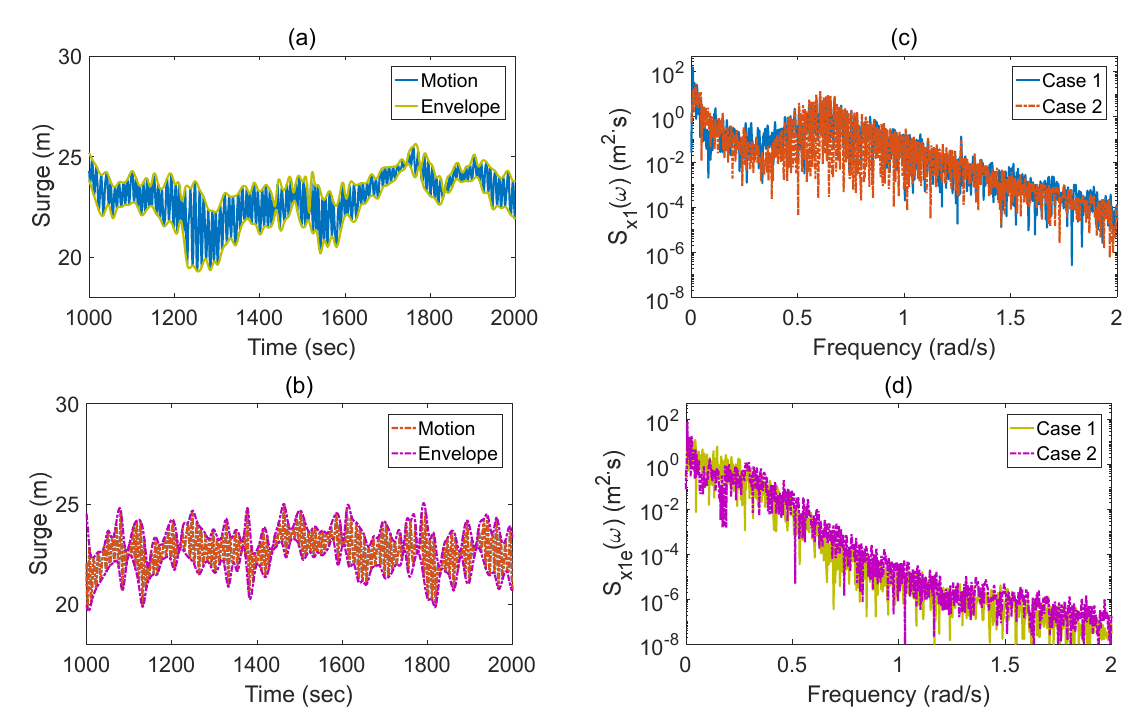
Figure 7. Time histories and power density spectra of surge motion. ( a ) Time histories under the wave group; ( b ) Surge responses under the stochastic wave; ( c ) The power density spectra of surge motion; ( d ) The power density spectra of surge motion envelope.